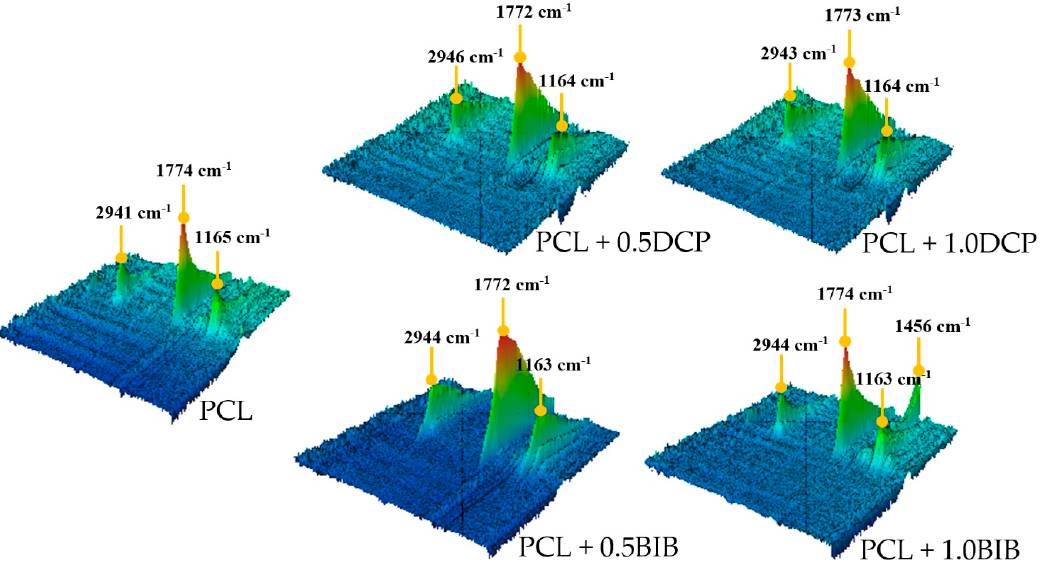
Figure 3. Three-dimensional image of TGA–FTIR analysis for PCL and PCL modified by DCP and BIB.